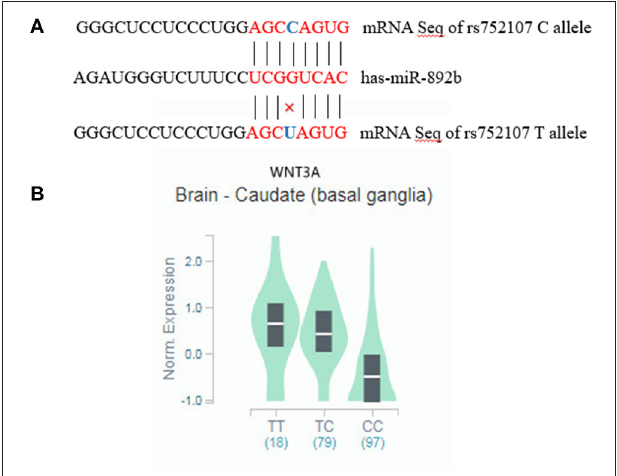
FIGURE 1 | (A) mRNA alignment analysis of has-miR-892b with rs752107. (B) WNT3A mRNA expression level among the different genotypes of rs752107 in